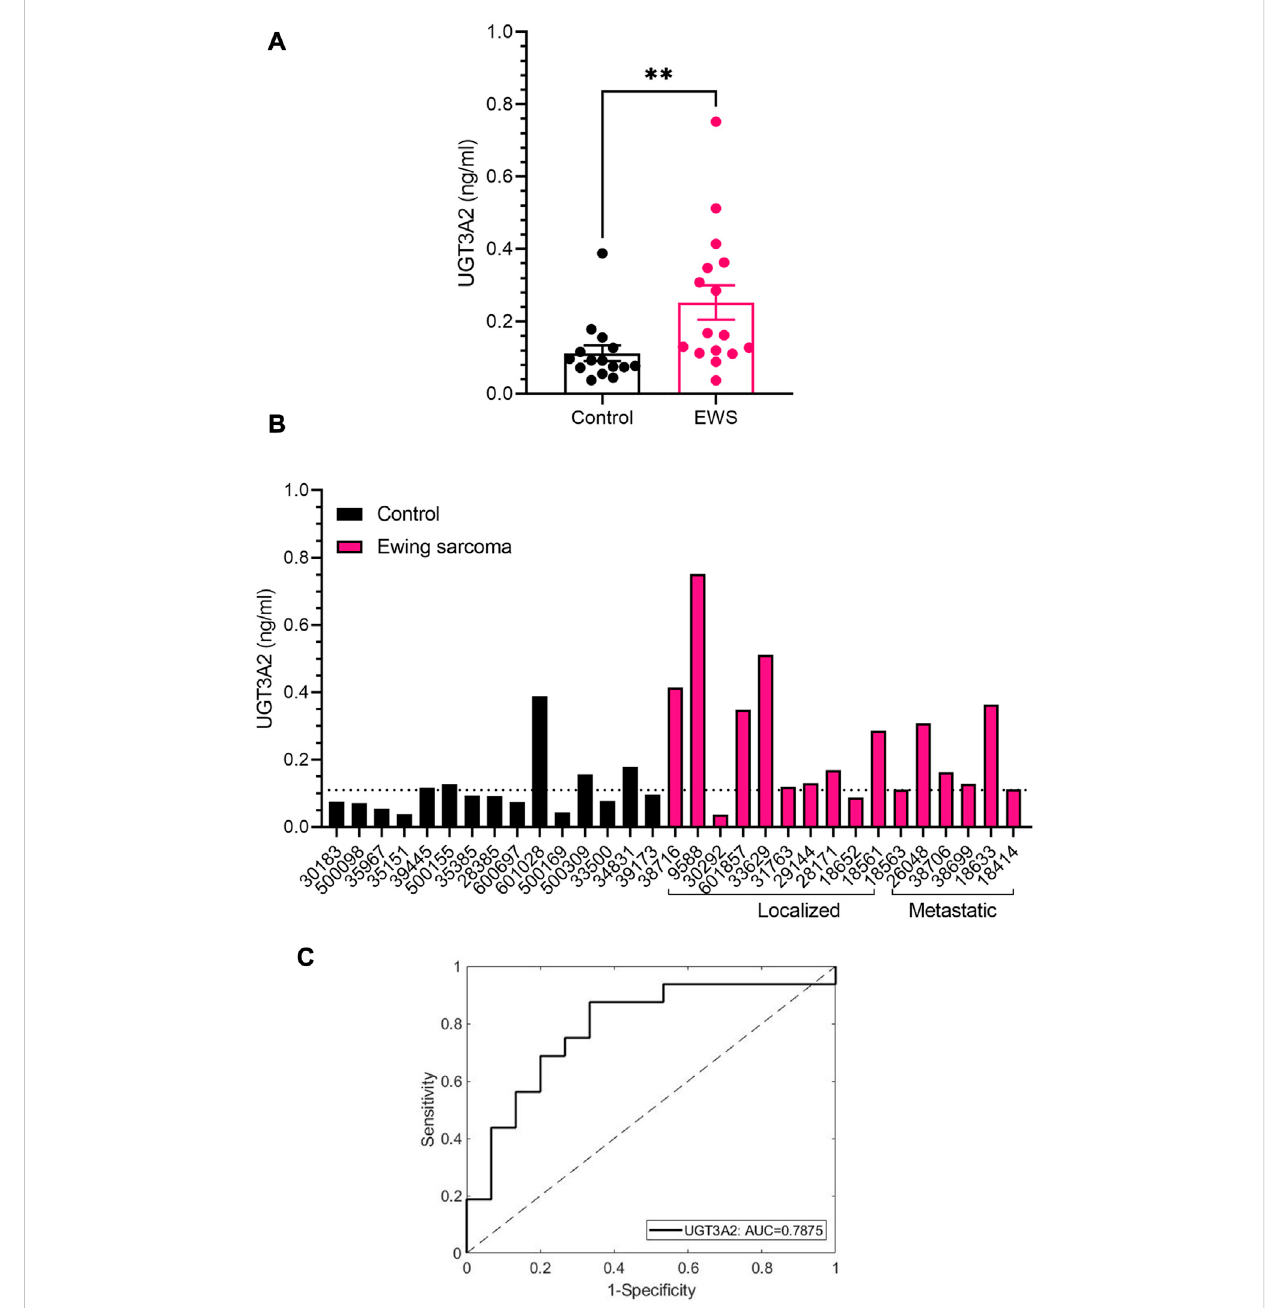
FIGURE 5 Clinical Validation of UGT3A2 Expression in Patient Plasma and Tumor Sections (A) UGT3A2 expression in control and EWS patient plasma-derived sEV samples as determined by ELISA. (B) Individual expression of UGT3A2 in healthy controls and EWS patient samples (localized and metastatic). Signi fi cant difference in expression was observed between healthy controls and EWS patients (** p = 0.0055 assessed by Mann-Whitney test). (C) ROC curve for UGT3A2 ELISA. The black line shows the mean area under the curve (AUC) plot, with the AUC value of